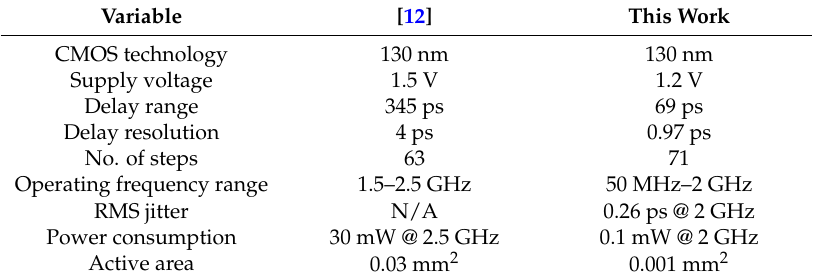
Table 3. Performance comparison of this work with a reported high-resolution DLL.